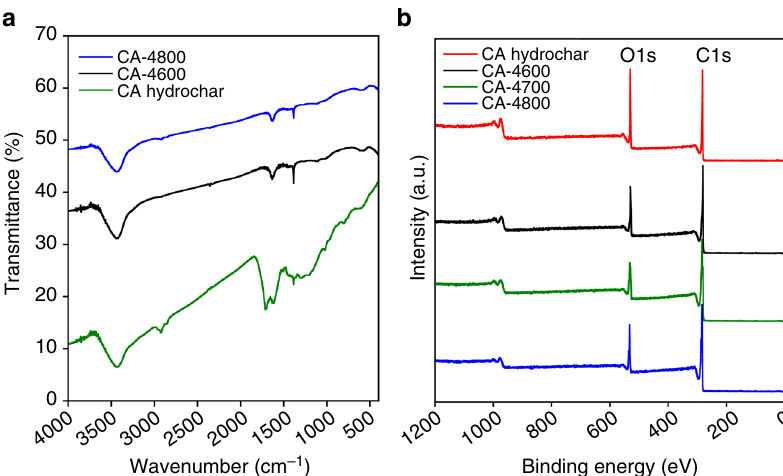
Fig. 3 Infra-red and X-ray photoelectron spectroscopy spectra of CA-hydrochar and activated carbons. a IR spectra and b XPS wide scan spectra of cellulose acetate-derived CA-hydrochar and activated carbons derived from the CA-hydrochar. The activated carbons are labelled as CA-4T, where 4 is the activation KOH/carbon ratio and T is the activation temperature in °C